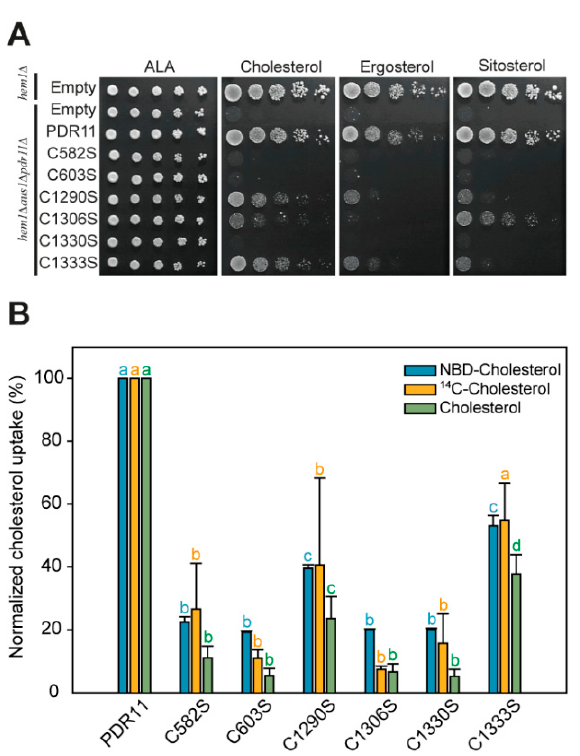
Figure 3. Pdr11p cysteine mutants show impaired ability to support sterol uptake. ( A ) Functional complementation of the hem1 ∆ aus1 ∆ pdr11 ∆ strain expressing genomically integrated wild-type and mutant variants of Pdr11p-GFP. Yeast strains hem1 ∆ and hem1 ∆ aus1 ∆ pdr11 ∆ transformed with empty plasmids were used as positive and negative controls, respectively. Yeast strains were serially diluted (five-fold) and grown on plates containing δ -aminolevulinic acid (ALA), cholesterol, ergosterol, or sitosterol, as indicated, for 5 days at 30 ◦ C. The experiment was repeated twice with identical results. ( B ) Sterol transport activity of plasmid-borne Pdr11p cysteine mutants in hem1 ∆ aus1 ∆ pdr11 ∆ cells. Uptakes of NBD-cholesterol, [ 14 C]-cholesterol, and cholesterol were measured as described in materials and methods. Results represent the means ± SD from two (unlabeled cholesterol) or three (NBD- and [ 14 C]-cholesterol) independent experiments and are expressed as percentage signal intensity relative to cells expressing wild-type Pdr11p; 100% corresponds to 589.8 ± 16.5 a.u. (NBD-cholesterol), 462.1 ± 74.9 a.u. ([ 14 C]-cholesterol), and 168.7 ± 54.0 µ g (cholesterol). For each individual cholesterol form, statistical significance was calculated using a two-way ANOVA analysis followed by Tukey HSD. Identical letters (a, b, c, d) above bars for a specific cholesterol form indicate values that do not show any statistically significant difference ( p < 0.01).